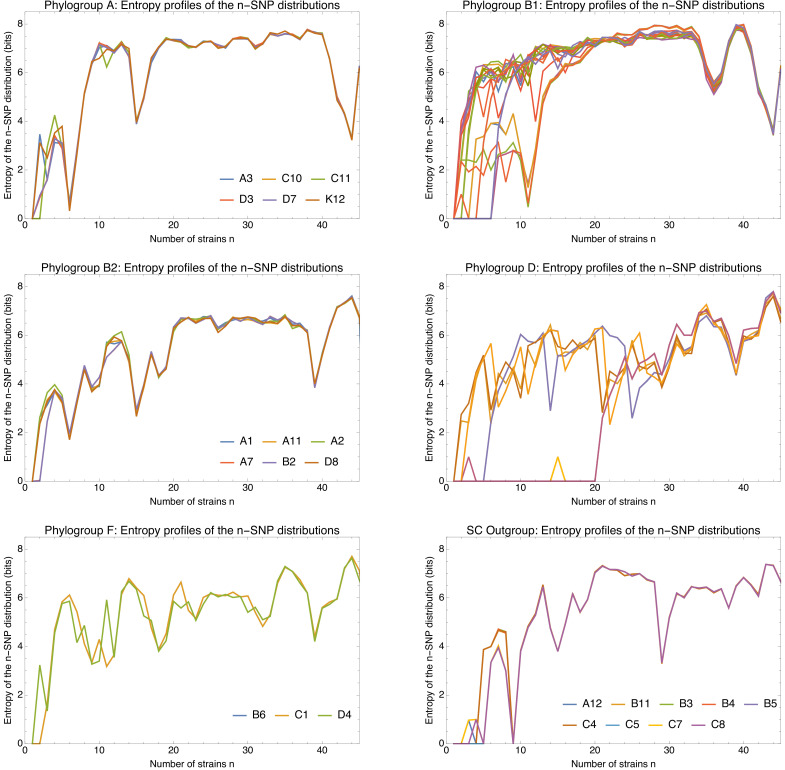
Entropy profiles of the n-SNP distributions for each of the E. coli phylogroups. Each panel shows the entropy Hn⁢(s) of the n-SNP distribution (vertical axis) as a function of n for each strain s (differently colored lines) within a phylogroup (indicated at the top of the panel). All entropies were calculated on the 5% homoplasy-corrected alignments. For phylogroups with less than 10 strains, the names of the strains are indicated in the legend of the plot. Note that the bottom right panel corresponds to the outgroup of nine strains that are highly diverged from all other strains. Note also that entropy profiles are perfectly overlapping for strains within groups that are so close that they had a recent clonal ancestor. For example, for the pairs (C10,C11) and (D3,D7) in phylogroup A, the pair (A7,B2) in phylogroup B2, and pair (B6,C1) in phylogroup F, the two profiles are identical and only one curve is visible.